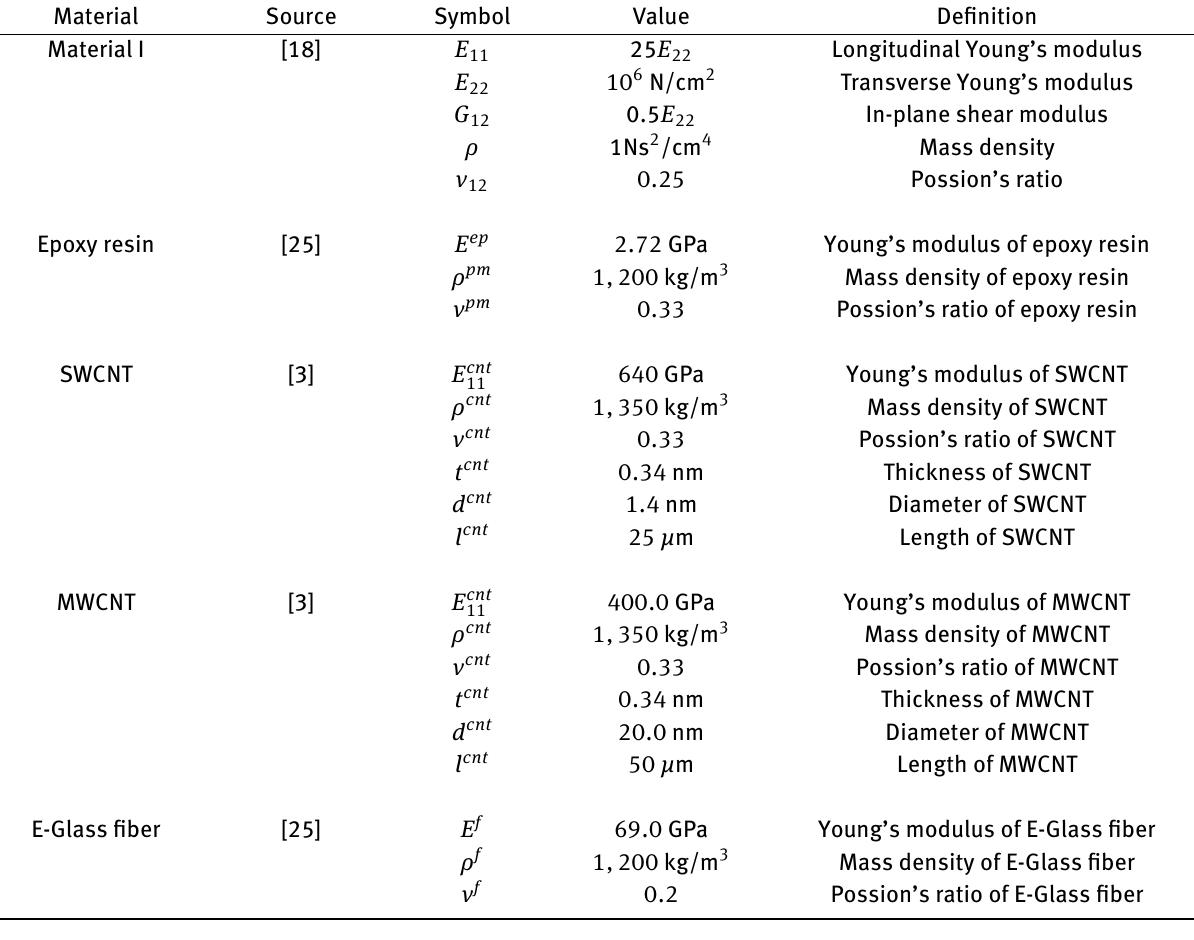
Table 1: Material and geometrical properties of the materials used in this study Material Source Symbol Value Definition Material I